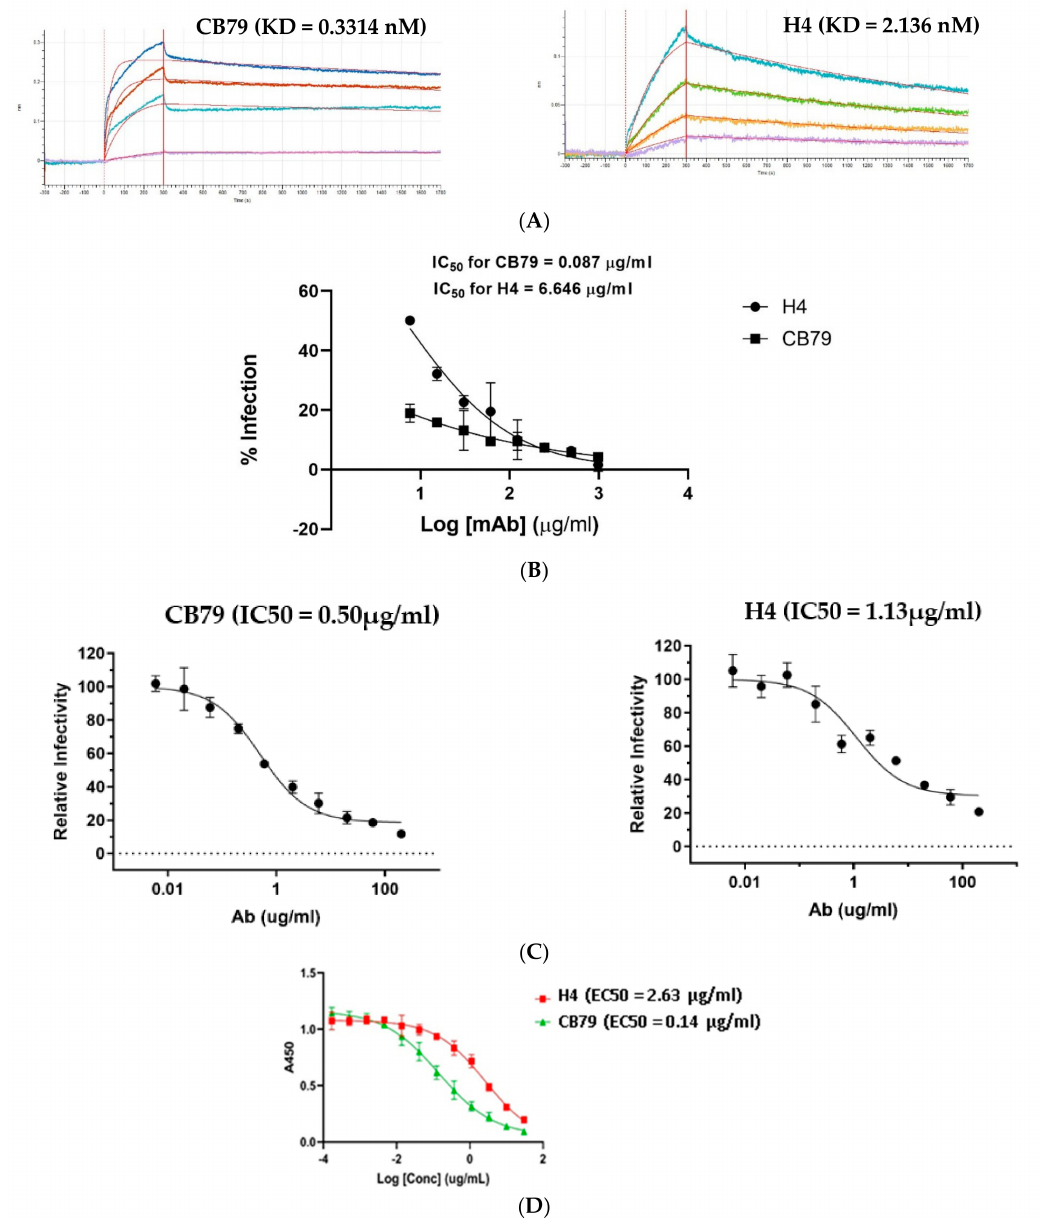
Figure 4. Biochemical and in vitro potency of CB79 compared to that of H4: ( A ) the binding kinetics of CB79 and H4 measured using biolayer interferometry on the Octet instrument; ( B ) PRNT-based neutralization using a live SARS-CoV-2 virus of CB79 and H4 as a function of the reduction in infection upon antibody treatment; ( C ) the neutralization of the pseudovirus comprising the SARS-CoV-2 spike protein of CB79 (left panel) compared to H4 (right panel); ( D ) the relative potency of CB79 and H4 in inhibiting the binding of the SARS-CoV-2 spike protein RBD to the human ACE2